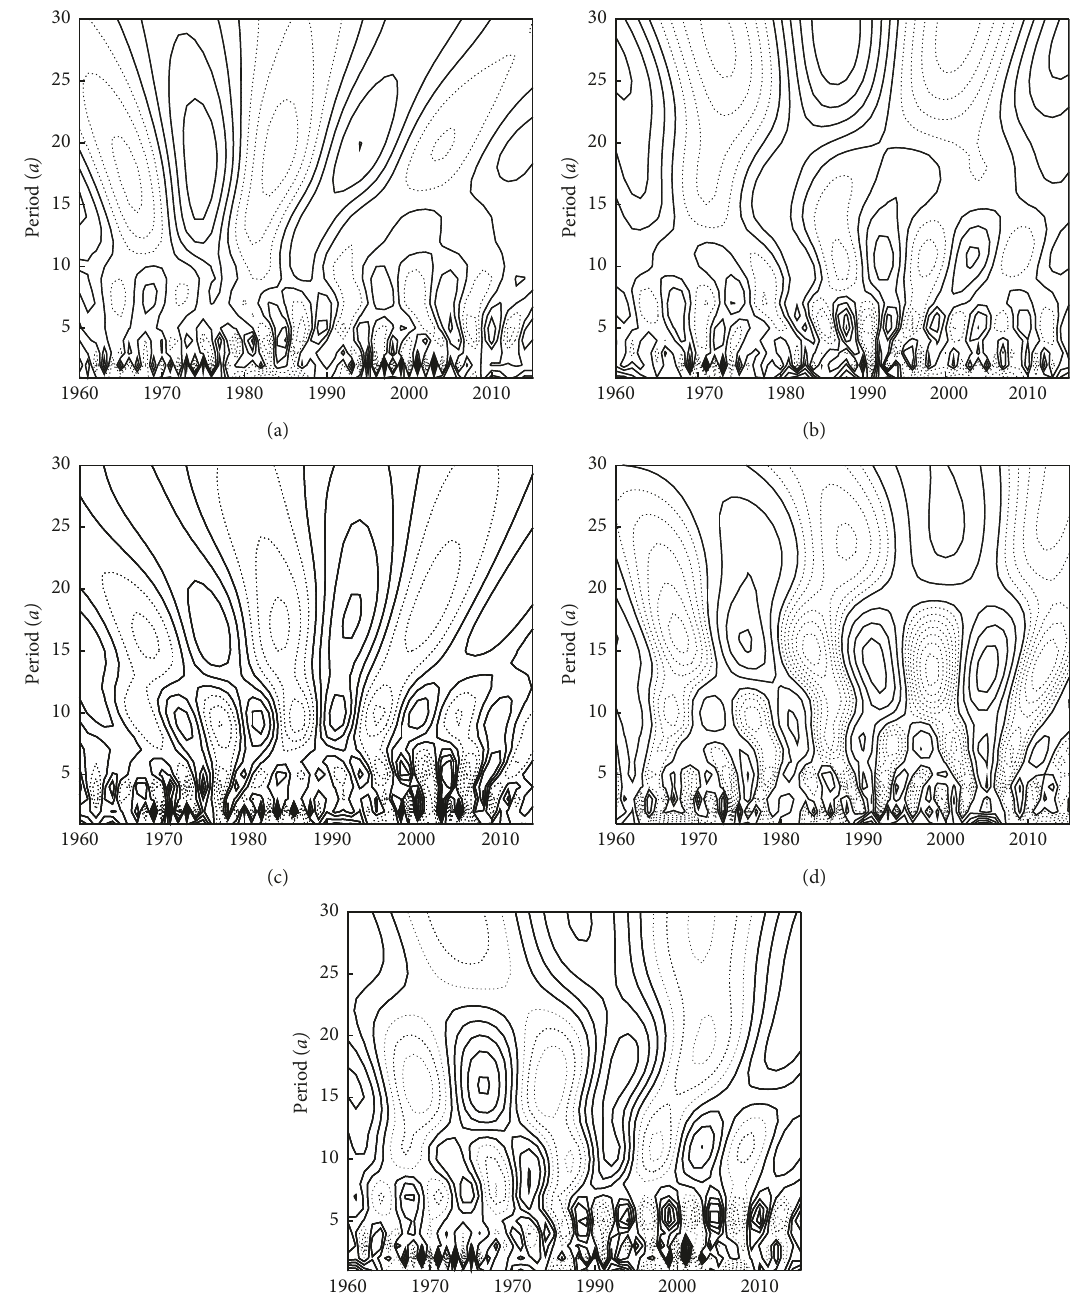
Figure 8: Time frequency graphs of wavelet transform in the